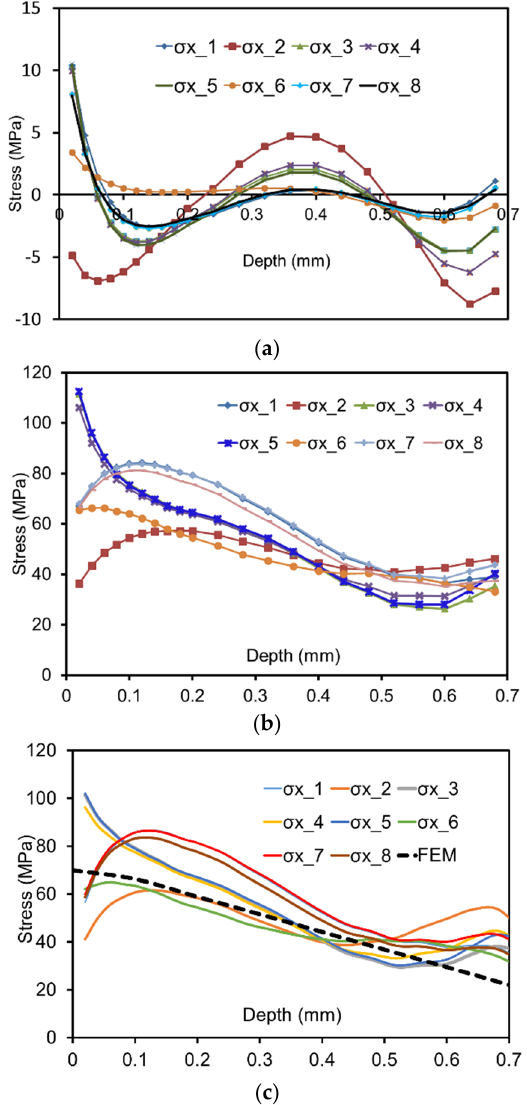
Figure 20. ( a ) Residual stress σ x in a GFRP sample without superimposed external loading, ( b ) measured residual stress σ x with loading and ( c ) validation of the obtained values. See text for details.